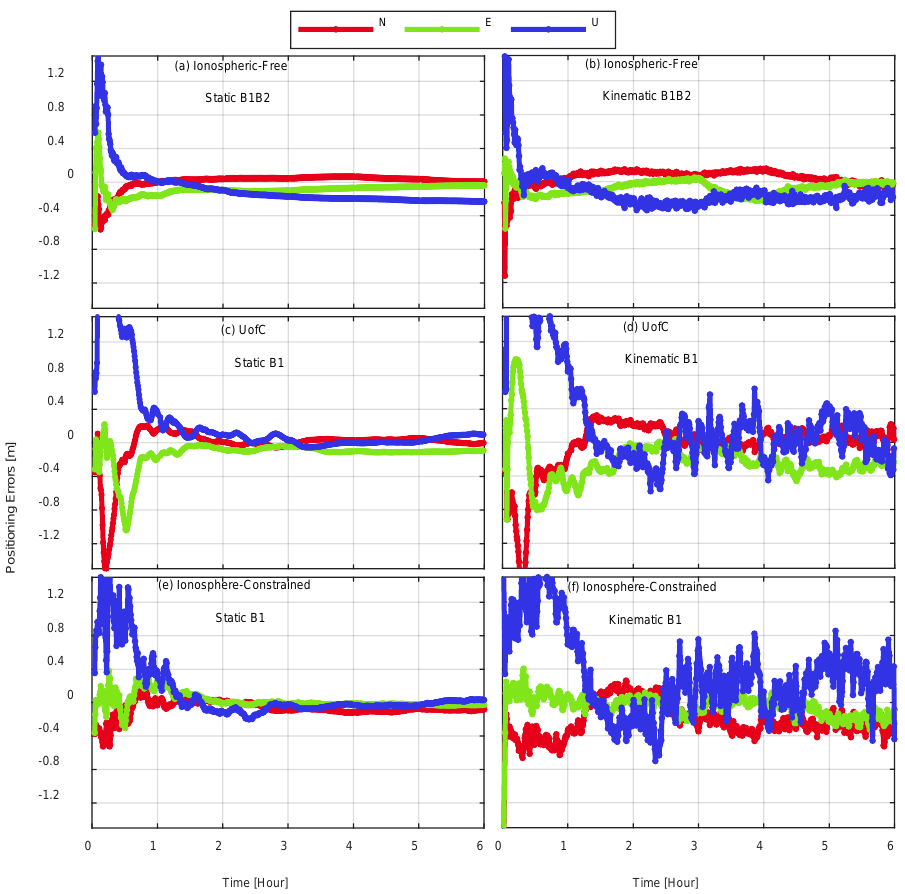
Figure 6. Typical BDS SBAS corrections-based PPP coordinate error series for ( a ) static B1B2, ( b ) kinematic B1B2, ( c ) static B1 UofC, ( d ) kinematic B1 UofC, ( e ) static B1 Ionosphere-constrained, and ( f ) kinematic B1 Ionosphere-constrained at SNMX station (DoY 37 in 2019).